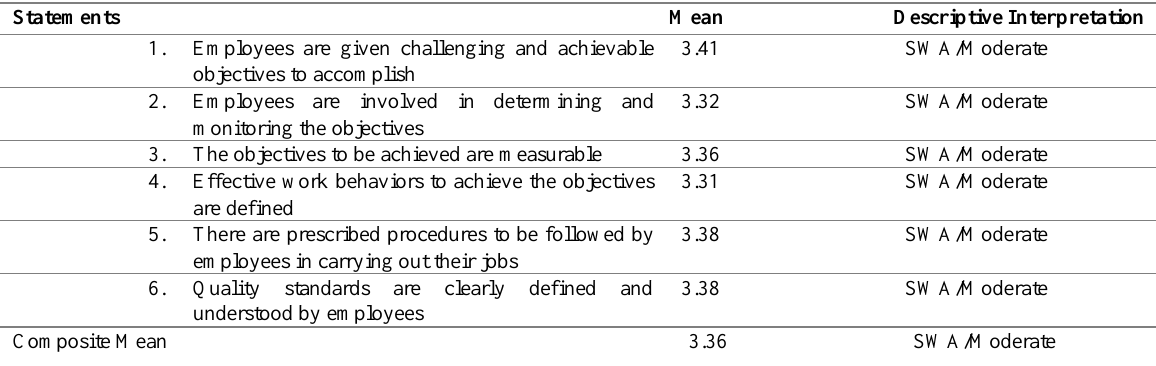
Table 2: Organizational Climate Along with